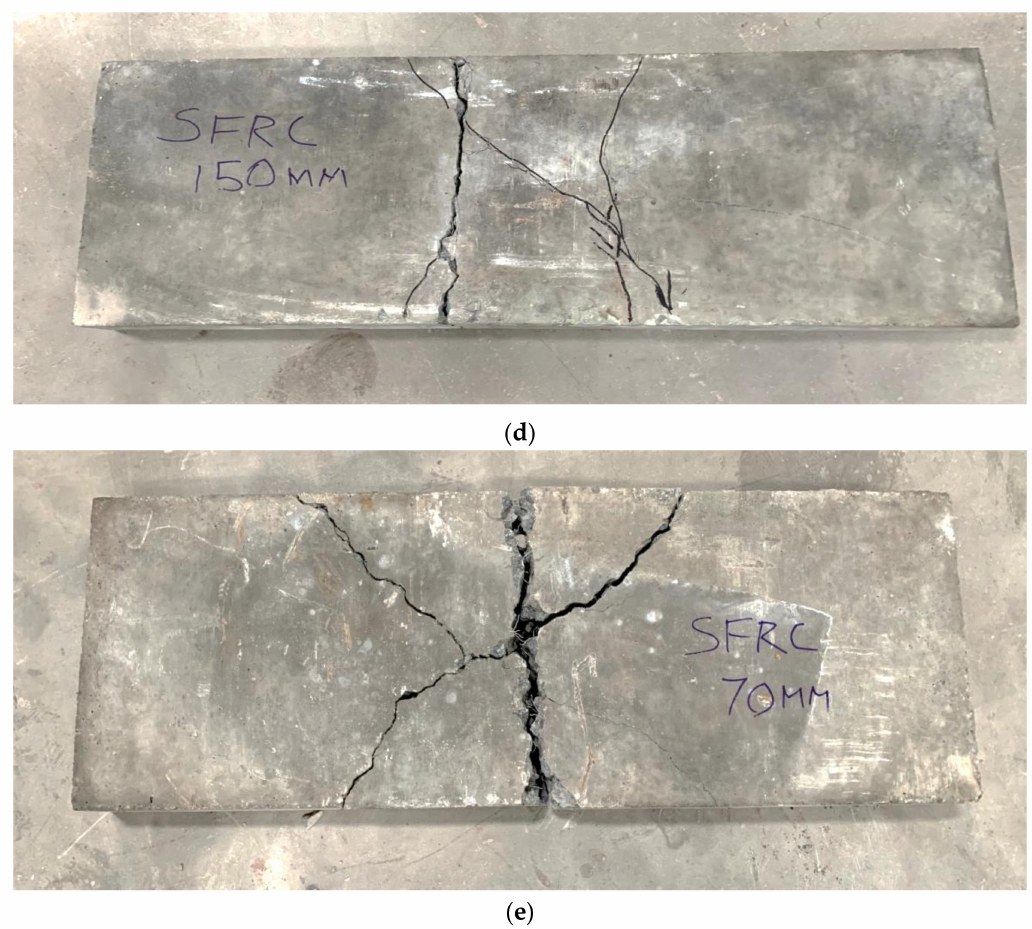
Figure 9. ( a ) Depiction of the crack pattern on the RCC slab due to repeated loading (Half cycle); ( b ) depiction of the crack pattern on the SFRC slab due to repeated loading; ( c ) depiction of the crack pattern on the SFRC + minimum reinforcement slab due to repeated loading; ( d ) depiction of the crack pattern on the SFRC + Lp 150 mm due to repeated loading; ( e ) depiction of the crack pattern on the SFRC + Lp 70 mm due to repeated